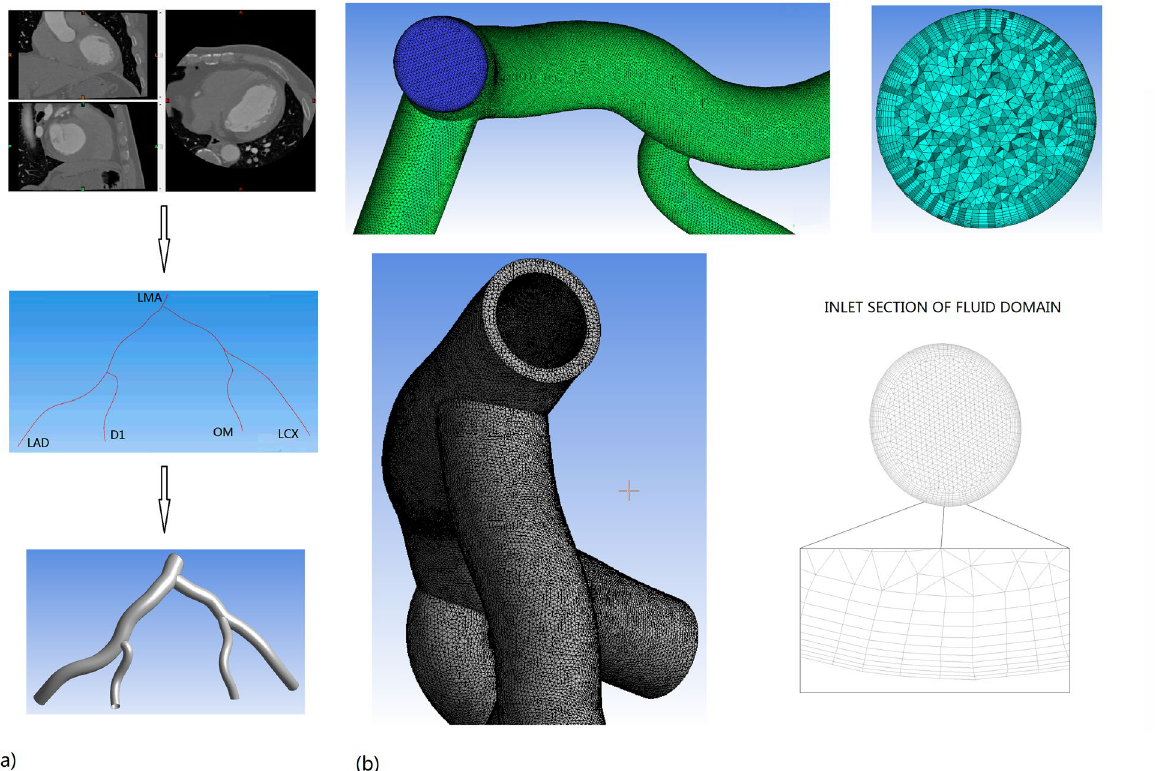
Figure 1. Reconstruction of 3D human left coronary artery. ( a ) Reconstructed human left coronary artery from the original CT coronary data of a 54-year-old male patient. LMA left main coronary artery, LAD left anterior descending artery, LCX left circumflex artery, D1 first diagonal branch of the LAD , OM left obtuse marginal branch. ( b ) Meshes of blood-phase & arterial wall of human left coronary